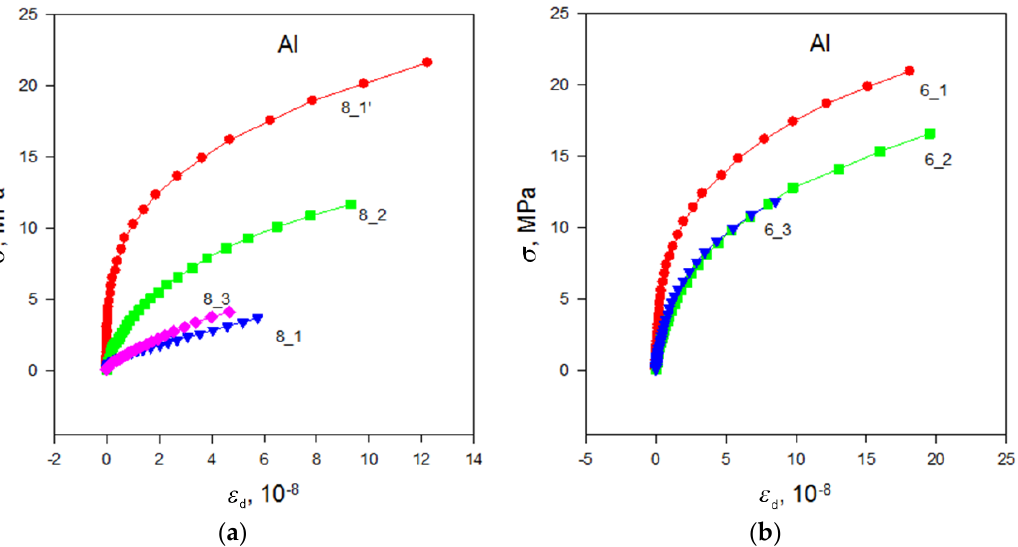
Figure 21. Diagrams of microplastic deformation σ ( ε d ) of Al wires of ( a ) A50 type after 10 years of service before (N8_1,2,3) and after (N8_1 ′ ) etching and ( b ) AC50 type after 20 years of service (N6_1,2,3). The measurements were taken at room temperature.